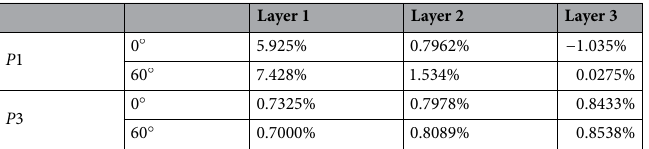
Table 3. Total absorbance error for each layer of the P 1 and P 3 approximations relative to a P 201 approximation that may be regarded as an exact